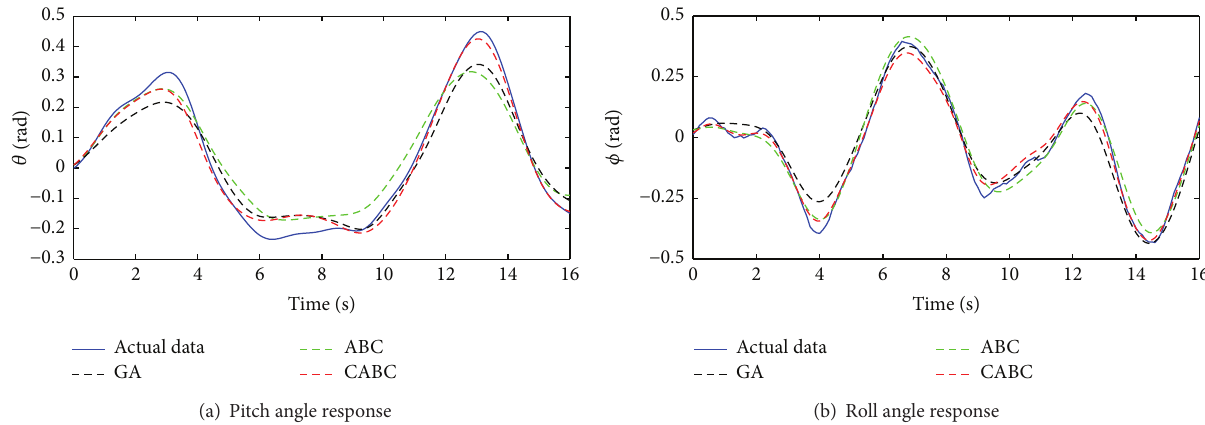
Figure 10: Comparison of the actual and estimated angles